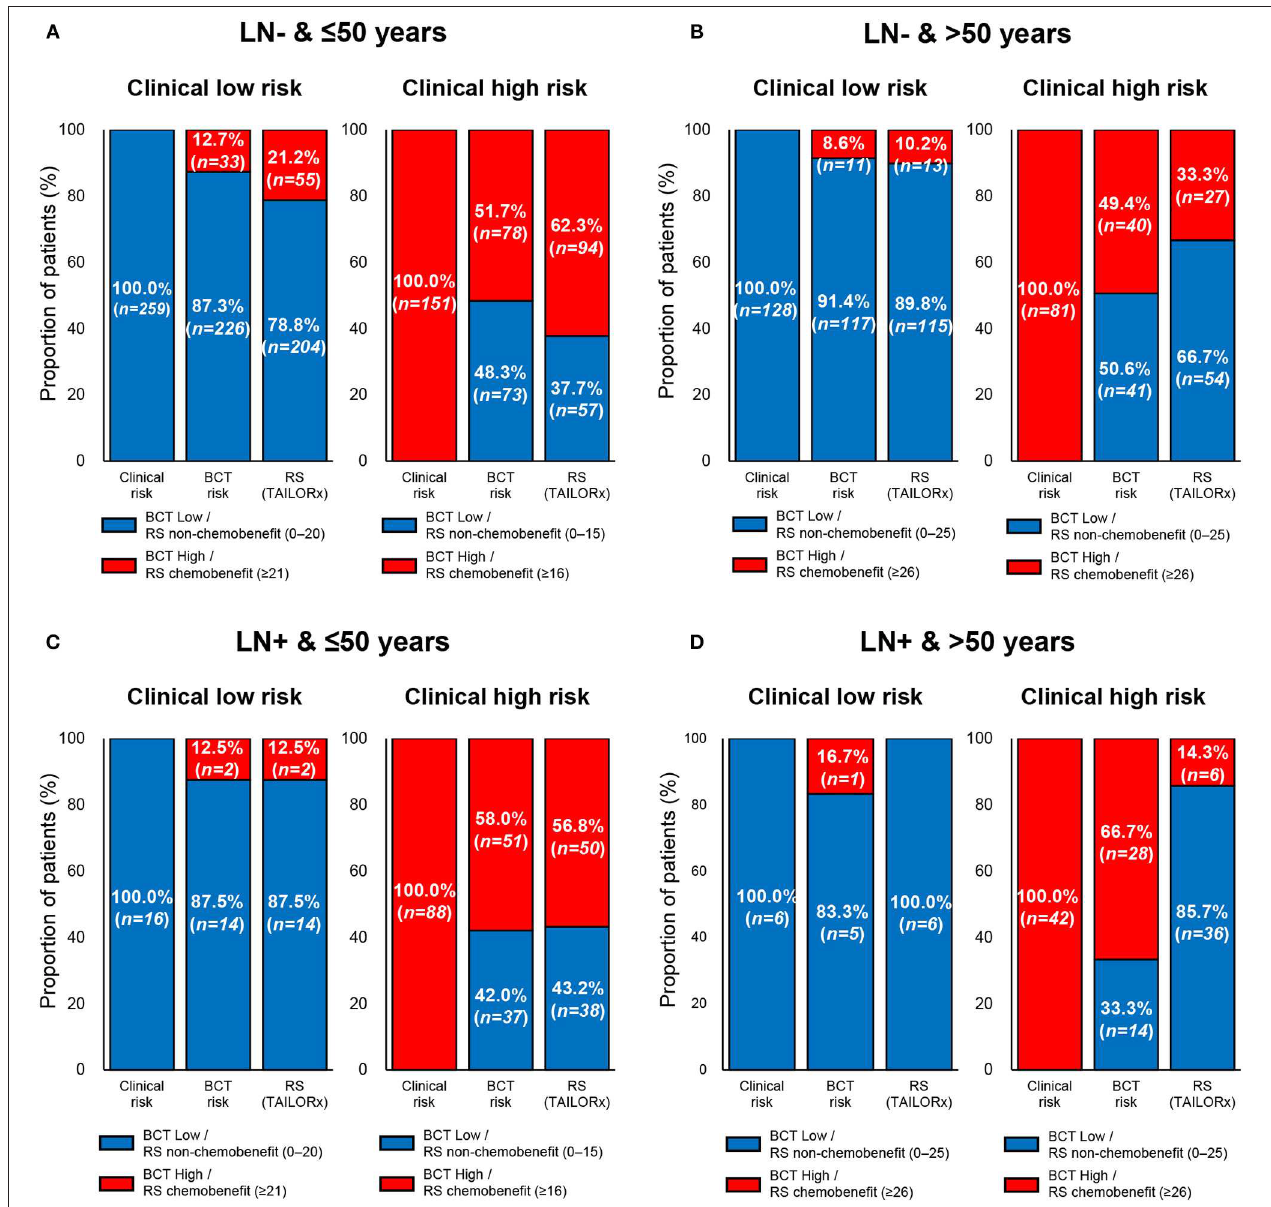
FIGURE 4 | Comparison of clinical risk with the risk classification by the BCT score or Oncotype DX RS by age within each nodal subgroup. Proportion of patients within each risk group according to clinical risk assessment, BCT score, or RS according to age and nodal status. (A) Patients aged ≤ 50 years with lymph node-negative (LN-) breast cancer ( n = 410). (B) Patients aged > 50 years with lymph node-negative (LN-) breast cancer ( n = 209). (C) Patients aged ≤ 50 years with lymph node-positive (LN + ) breast cancer ( n = 104). (D) Patients aged > 50 years with lymph node-positive (LN + ) breast cancer ( n = 48). Clinical risk was